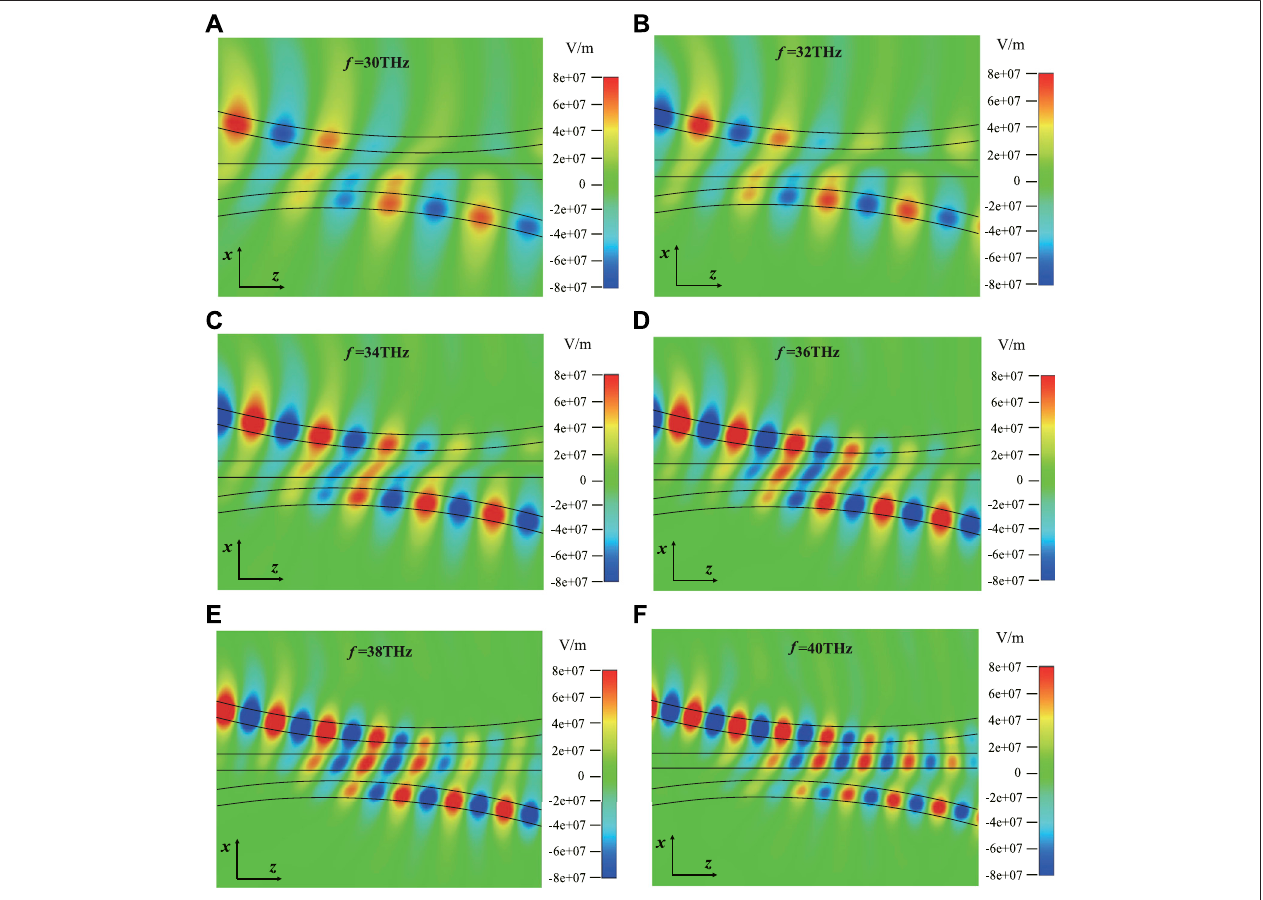
FIGURE 8 | Full-wave simulation results of our device. The distributions of E- fi eld on the y = 0 plane of our device based on simulation at different frequencies (A) 30 THz, (B) 32 THz, (C) 34 THz, (D) 36 THz, (E) 38 THz, and (F) 40 THz.